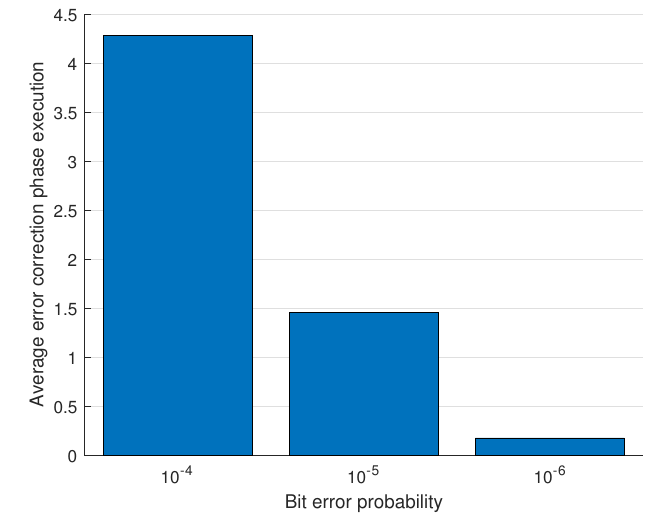
Figure 6. CFLED average phase execution increase for a maximum of 24 correction phase